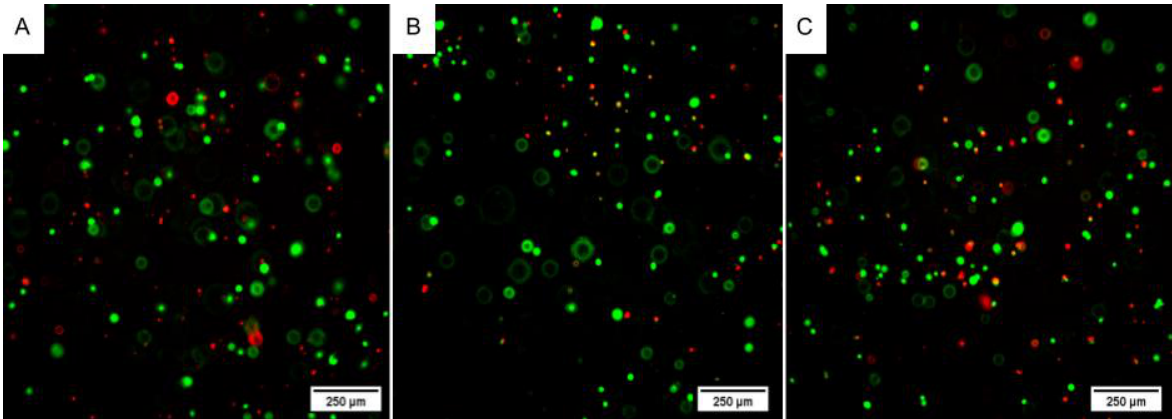
Figure 7. 3D bioprinting with WJ-MSC. ( A ) Cell viability in the 3D structure after 24 h; ( B ) Cell viability in the 3D structure after 48 h; ( C ) Cell viability in the 3D structure after 72 h. The cells in green were viable, and in red, non-viable as dead. Images obtained using a high-throughput microscope In Cell Analyzer 2000 (GE Healthcare ® , Chicago, IL, USA).